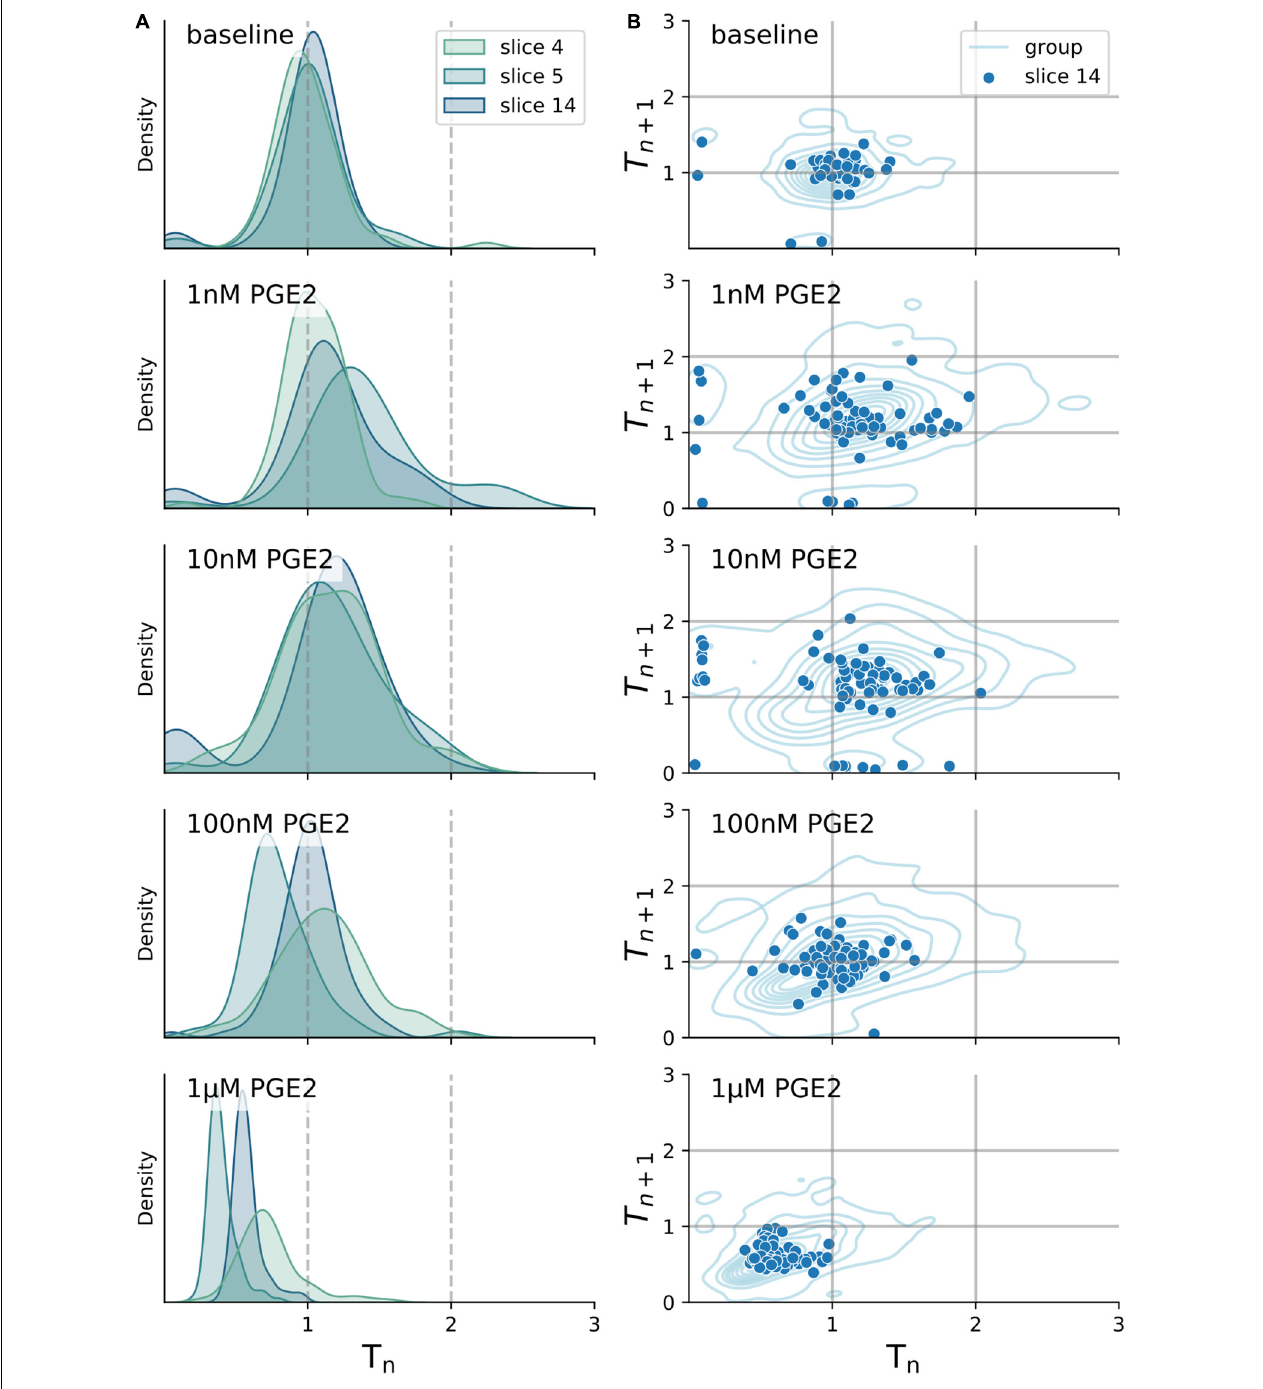
FIGURE 2 | Burst period stays unimodally distributed after exposure to increasing levels of PGE2. (A) Distribution of burst period (T n ) normalized to baseline of three exemplary transverse slices after exposure to 1 nM–1 µ M PGE2. (B) Correlation of T n to subsequent burst period (T n + 1 ) normalized to baseline for a single exemplary transverse slice (dots) and combined periods of all slices (lines). All distributions shown are unimodal as tested for by the Hartigan’s Dip test ( p >